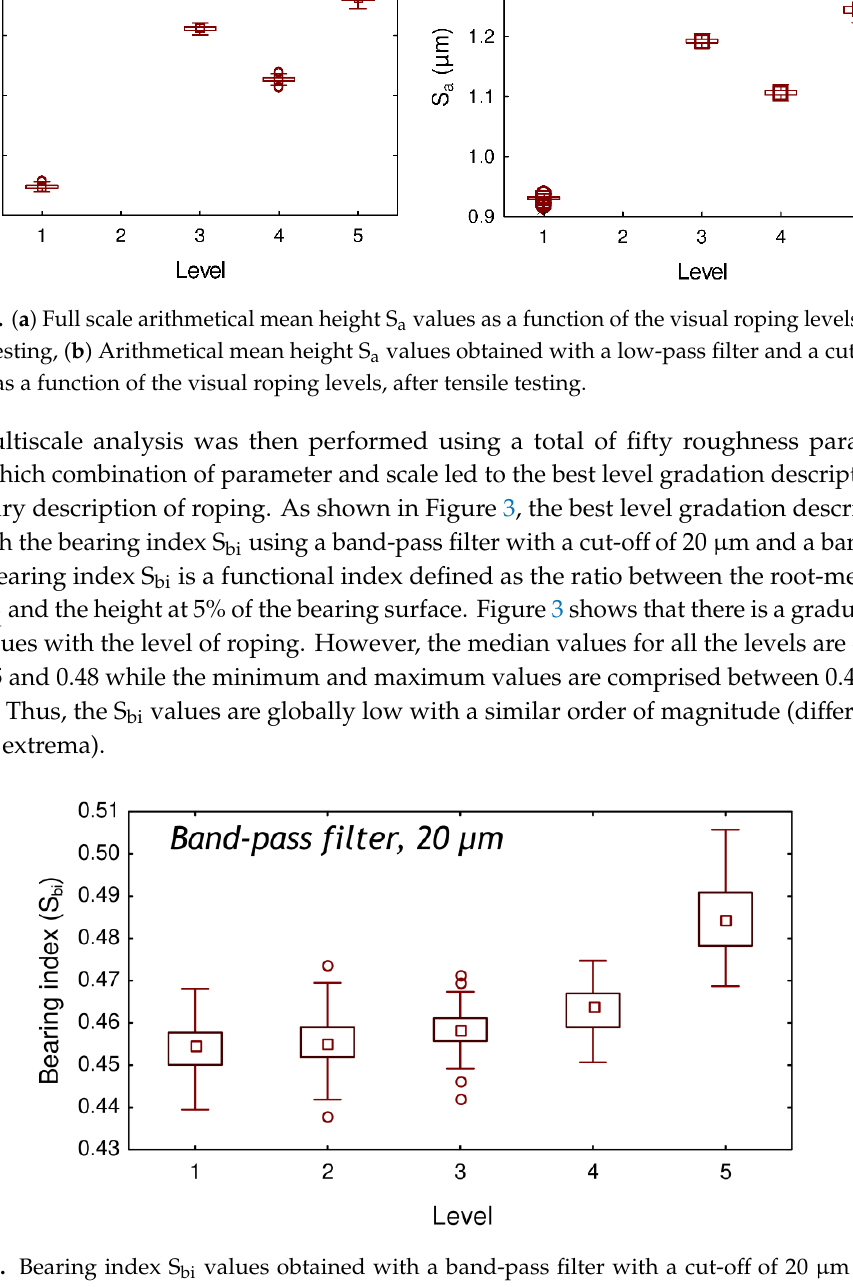
Figure 2. ( a ) Full scale arithmetical mean height S a values as a function of the visual roping levels, after tensile testing, ( b ) Arithmetical mean height S a values obtained with a low-pass filter and a cut- off of 200 µm as a function of the visual roping levels, after tensile testing.